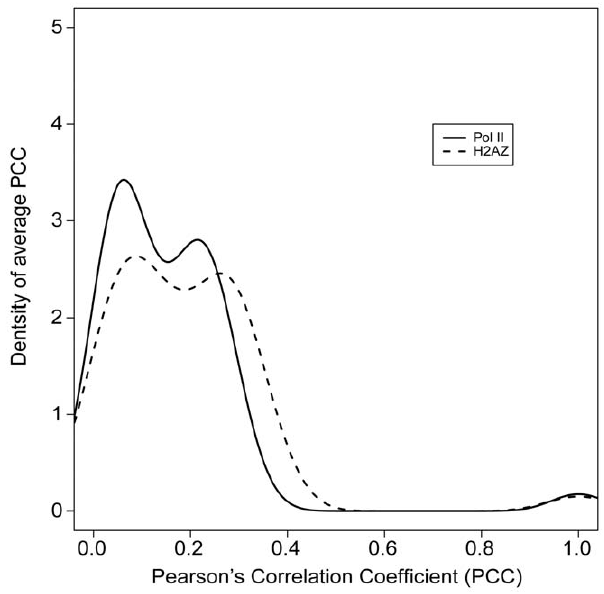
Figure 3. The distribution of PCCs among the 41 histone modifications, Pol II and H2A.Z levels in the promoter regions of CD4 + T cells.